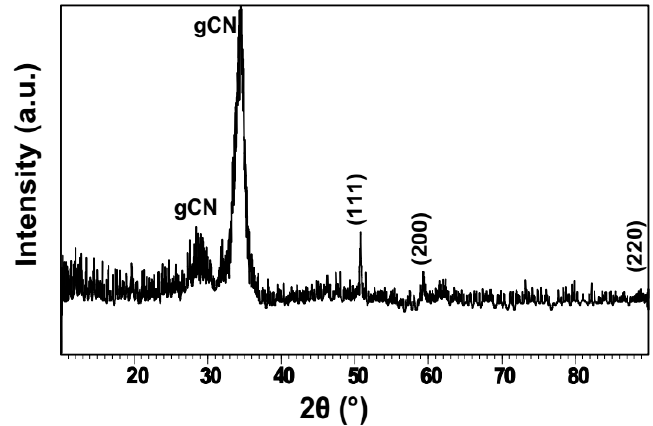
Figure 3. Powder XRD pattern (obtained using Co K α radiation, λ = 1.79026 Å) of the Cu/gCN material formed using pulsed laser ablation in acetonitrile. The weak sharp peaks due to crystalline Cu NPs are labeled with their {hkl} values. The strong broad features are due to the gCN support generated during the laser ablation synthesis from acetonitrile. Table 1. Summary of X-ray diffraction data obtained using Co K α radiation ( λ = 1.79026 Å) for a typical Cu/gCN material prepared using pulsed laser ablation in acetonitrile. * The assignment of peaks for gCN is discussed in the text.